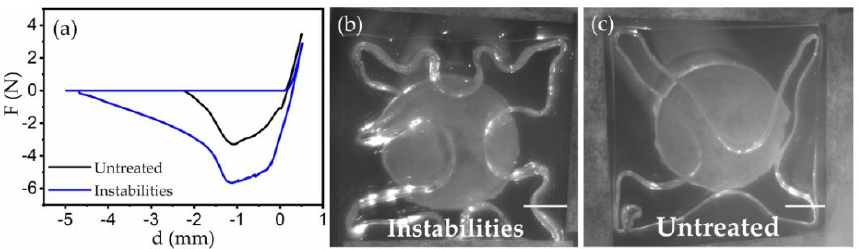
Figure 5. Contact line variations during the indentation tests. ( a ) Force – displacement curves for a glass coverslip indenting the samples with and without instabilities. ( b ) Fingering pattern for instabilities sample and ( c ) normal smooth contact line for untreated sample. Scale bar = 0.5 cm.